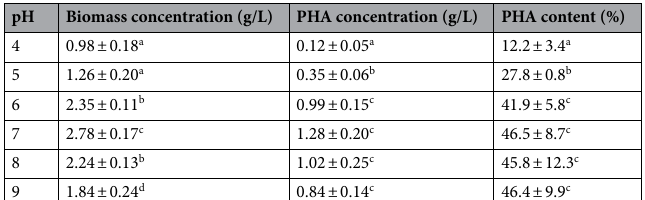
pH Biomass concentration (g/L) PHA concentration (g/L) PHA content